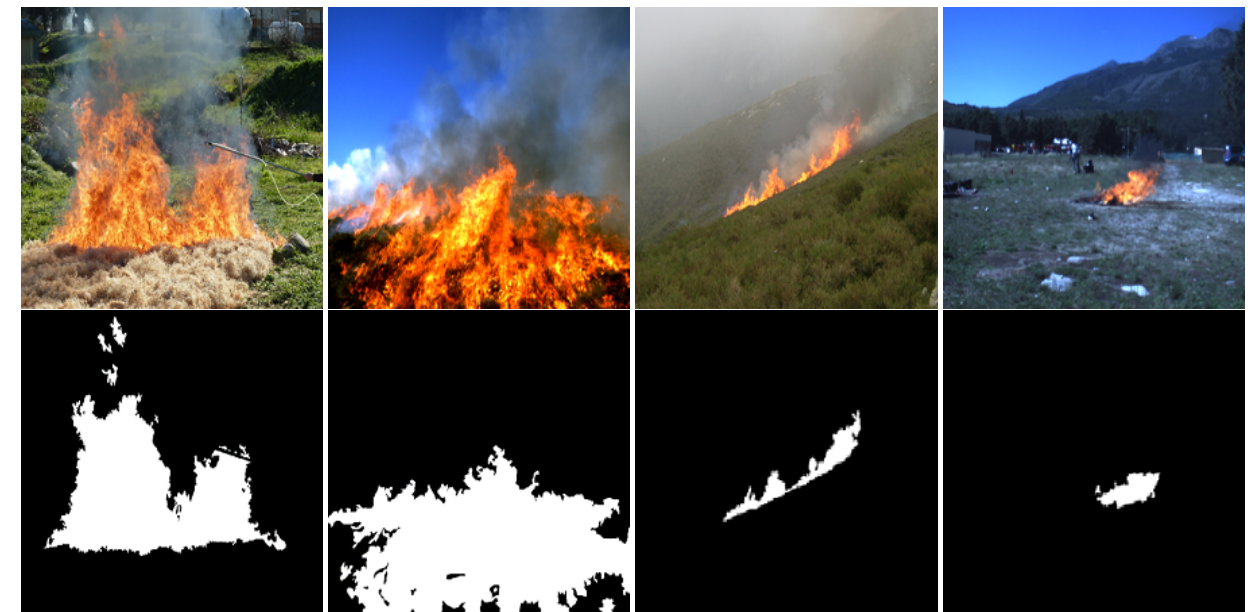
Figure 8. Examples from the CorsicanFire dataset. ( Top ): RGB images; ( Bottom ): their correspond- ing masks.